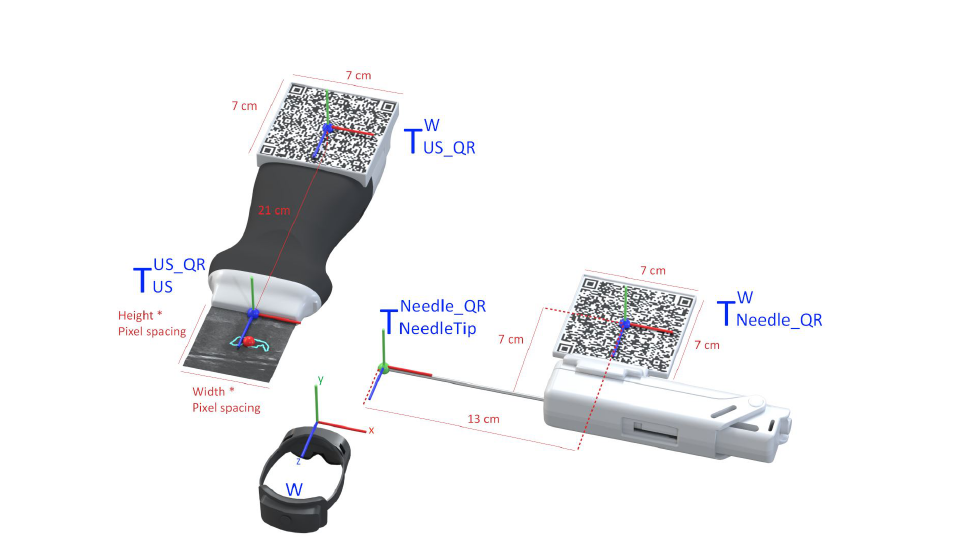
Figure 4. Representation of the conversion between the real-world objects and their virtual location. The physician needs to visualize the needle in real-time while performing the ultra- sound imaging to ensure that the needle will hit the targeted lesion [33]. In this work, strategies were implemented to assist the user in aligning the biopsy needle with the US image plane. This was accomplished by displaying a line from the tracked needle tip, as shown in Figure 4 (green ball), to the predicted lesion that changes colors depending on the needle’s alignment. The colors vary between green, which indicates alignment, and red, indicating unalignment, as shown in Figure 3 (red line) and Figure 5. The calculation tip and the lesion position and the normal vector of the US image hologram plane. The computed, as described in [34]. The ideal angle value is precisely 90 ◦ , meaning that both vectors form a right angle. This value, however, is virtually impossible to reach in the application context due to hand movements and computational uncertainties. An angle range was, therefore, empirically defined, ranging between 86 and 94 ◦ .